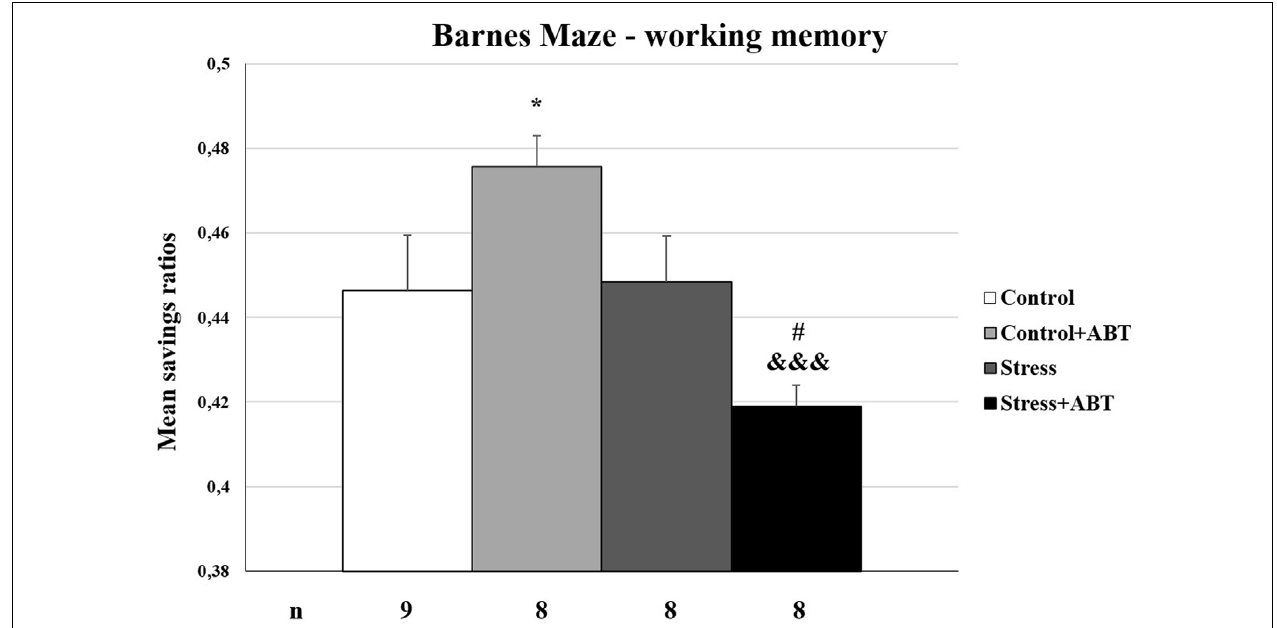
FIGURE 6 | Effects of stress and long-term ABT-239 pre-treatment on working memory expressed in mean savings ratios tested in BM. Columns represent mean savings ratios ± SEM from 6 days of trials obtained from n rats indicated at the bottom of the figure. The three groups demonstrated significantly different results in mean savings ratio achieved in the BM Control in comparison with Control + ABT (* p < 0.001), Control + ABT vs. Stress + ABT ( # p < 0.05), and Stress vs. Stress + ABT ( &&& p <